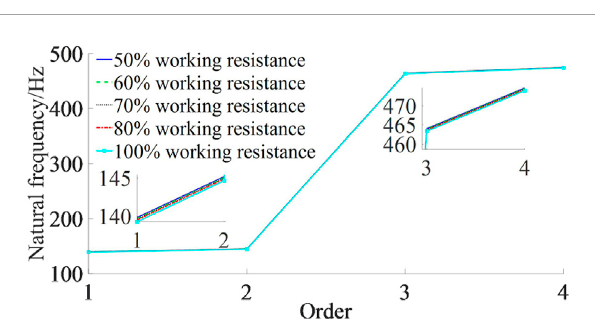
FIGURE 13 Column frequency – order curves for different setting